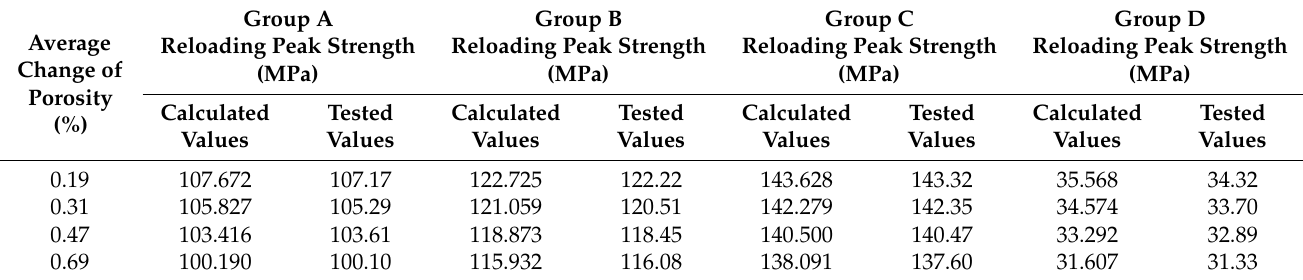
Table 4. Calculated and tested values of the peak strength decay model for reloading after freeze-thaw cycles for four groups of unloaded-damaged